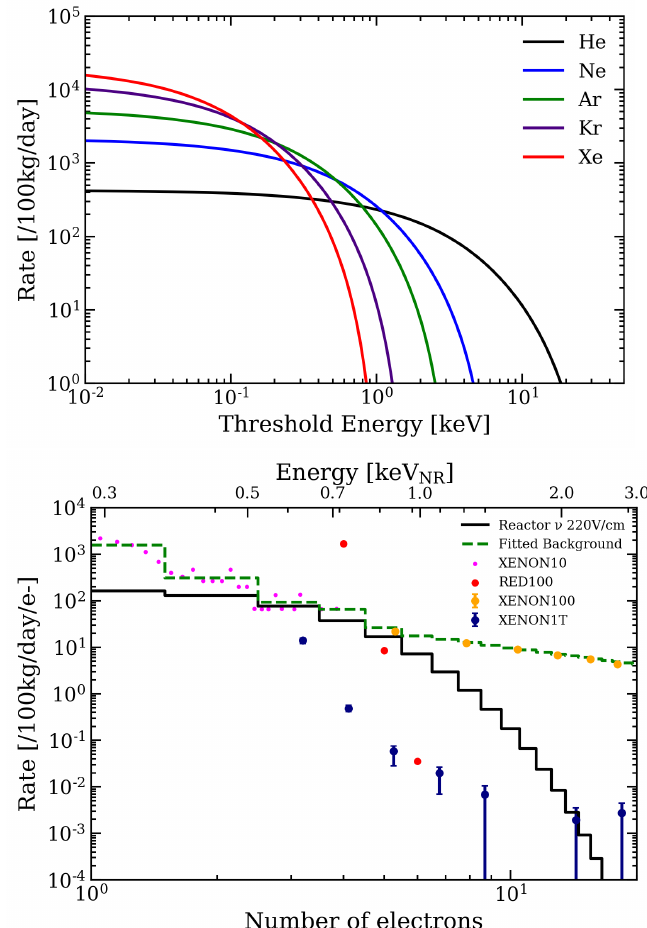
Figure 1. ( Top ): calculated CE ν NS rates in different noble elements from reactor anti-neutrinos with a flux of 6.3 × 10 12 cm − 2 s − 1 and assuming 7.6% 238 U, 26% 235 U, 14.8% 241 Pu, 51% 239 Pu fission elements composition. ( Bottom ): expected reactor anti-neutrino CE ν NS rates in number of detected electrons, compared with the background rates measured in several experiments. A “Fitted Background” (dashed green) from the XENON10/XENON100 is used as a benchmark background rate in a 10–100 kg liquid xenon detector for this study. The difference of background rates at this energy range from different experiments are due to their relative size and operation locations (see text for